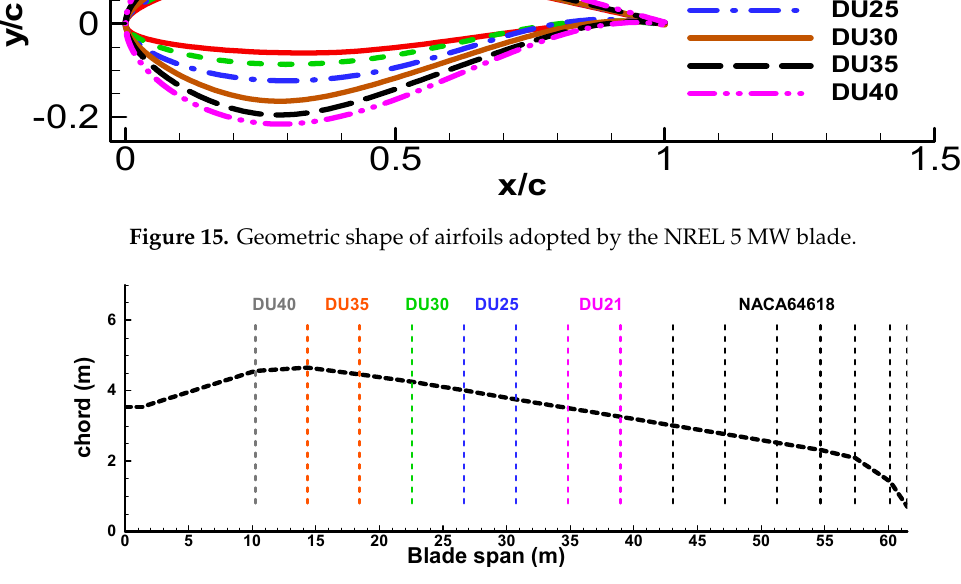
Figure 16. Span-wise airfoil arrangement of the NREL 5 MW wind turbine blade.